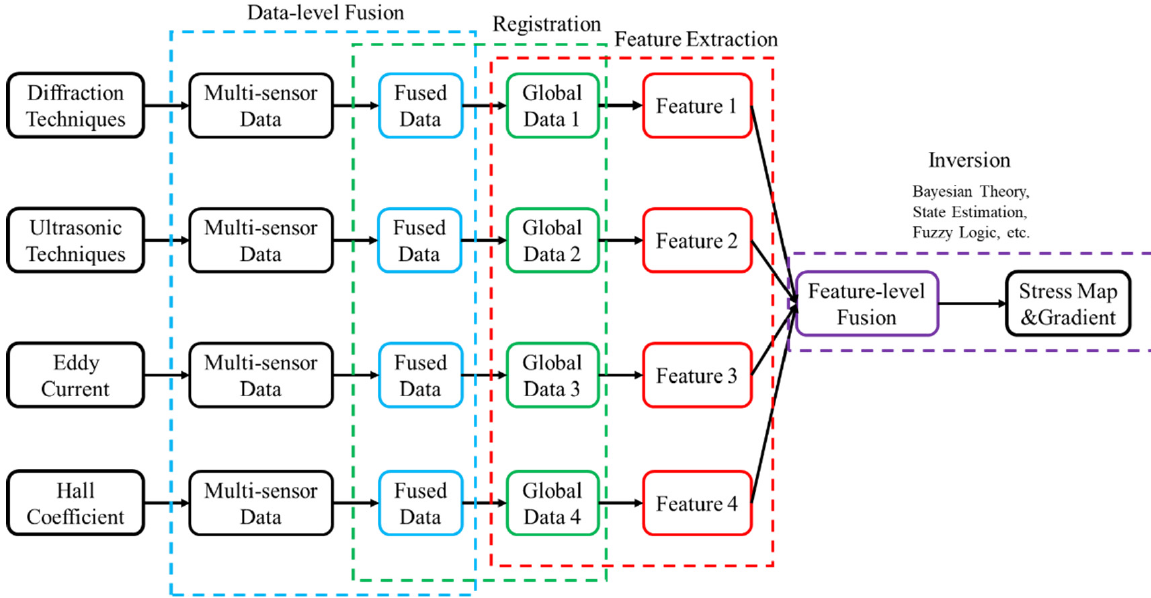
Figure 12. Flow chart of NDE data fusion.